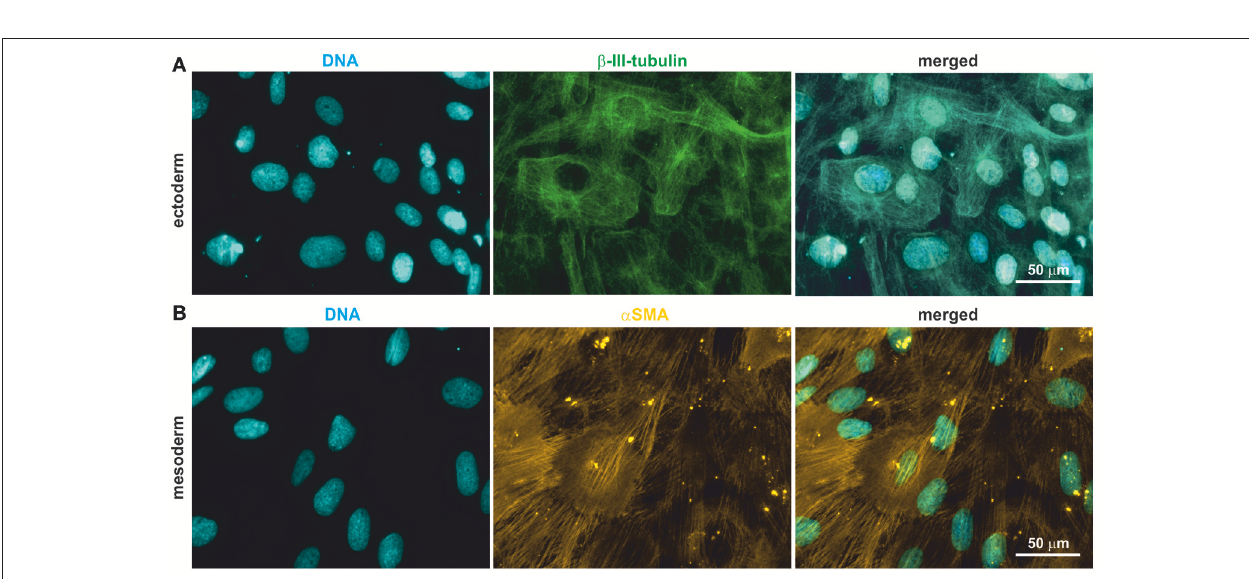
FIGURE 4 | oNCSCs differentiate into cells of the ectodermal and mesodermal lineage. (A) oNCSCs were differentiated toward the ectodermal fate followed by immunocytochemical analysis. Cells subjected to ectodermal differentiation showed β -III-tubulin expression (middle panel). Nuclei were counterstained using DAPI. Scale bar: 50 µ m. (B) Smooth muscle actin ( α SMA) was expressed in oNCSCs after mesodermal differentiation. Nuclei were counterstained using DAPI. Scale bar: 50 µ m.